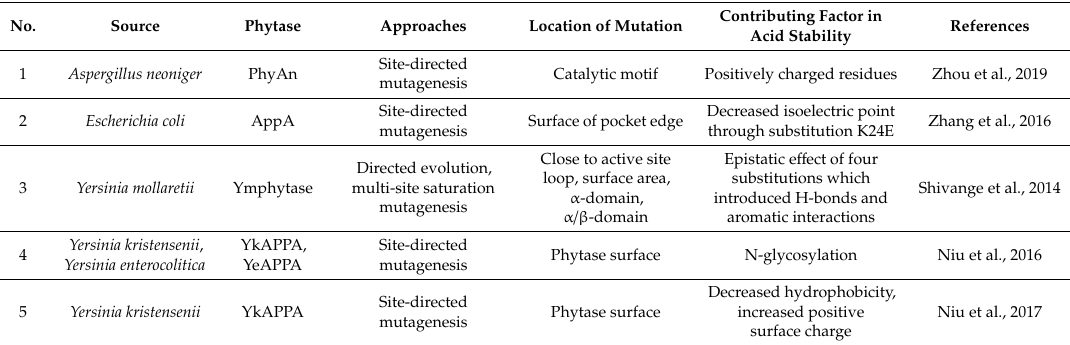
Table 2. Factors a ff ecting phytase acid